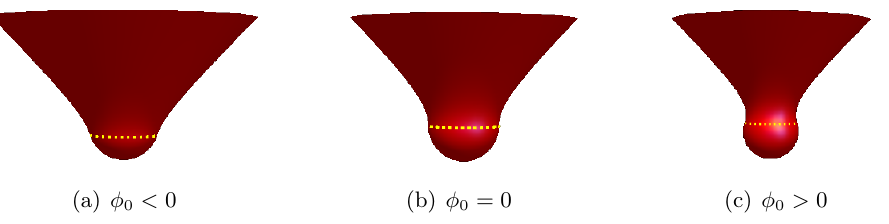
Figure 7 . The di(cid:11)erent interpolating geometries as a function of (cid:30) 0 . In general, negative (cid:30) 0 solutions contain a smaller part of the sphere than the (cid:30) 0 = 0, while (cid:30) 0 > 0 contain a larger part. with (cid:30) < 0. Smoothness requires (cid:28) (cid:24) (cid:28) + 2 (cid:25) . At tanh (cid:26) h interpolates to one with negative